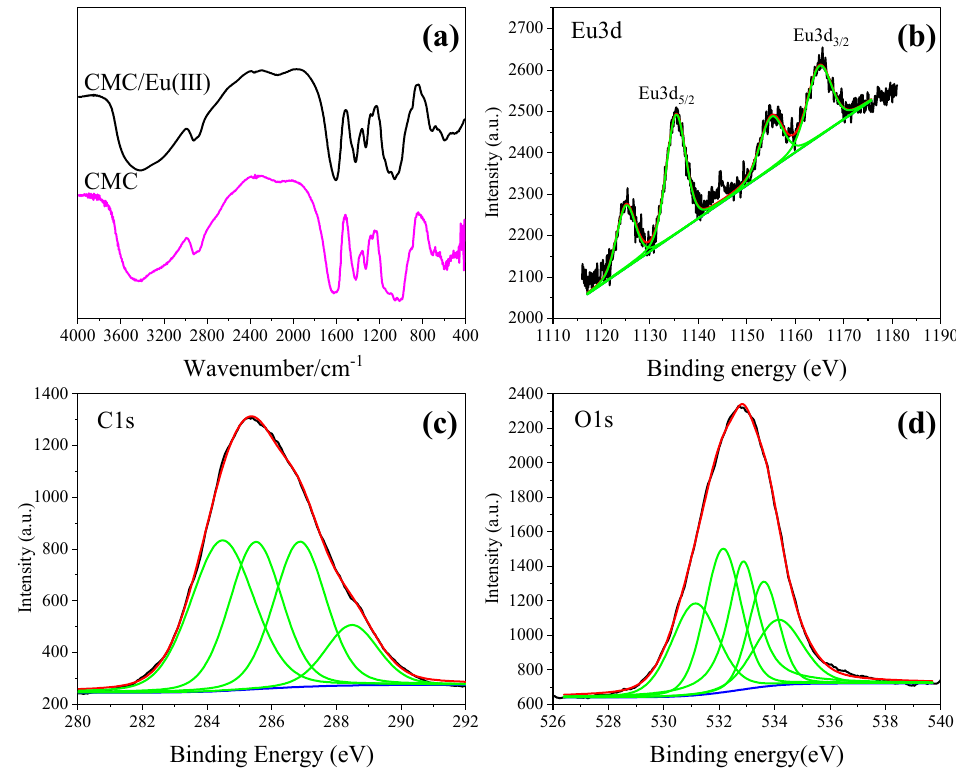
Figure 1. FTIR and XPS spectra of CMC/Eu (III) composite. ( a ) FTIR spectra; ( b – d ) XPS spectra. Figure 1 . FTIR and XPS spectra of CMC/Eu ( Ⅲ ) composite. ( a ) FTIR spectra; ( b – d ) XPS spectra.